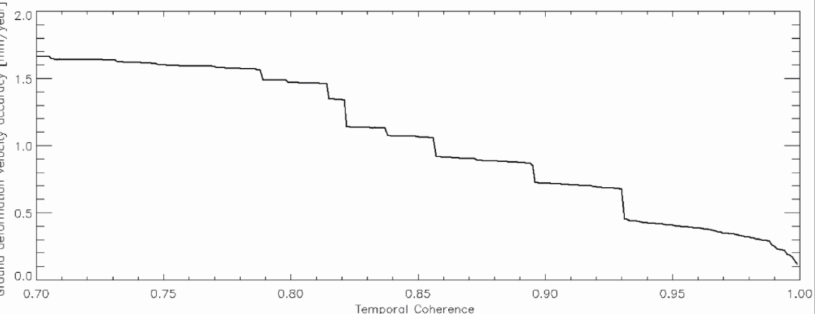
Figure 14. The plot of the ground displacement rate absolute error of the SBAS measurements vs. the temporal